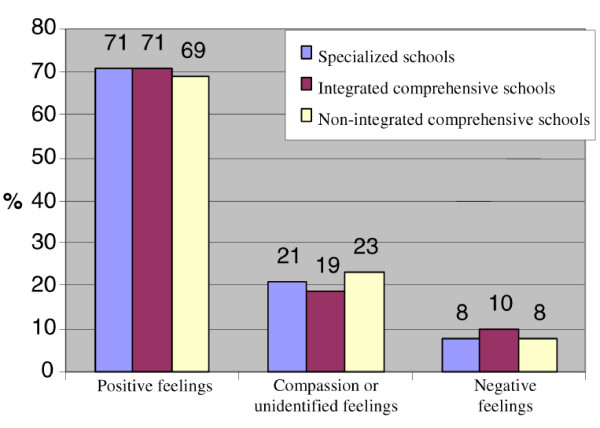
The attitudes of schoolchildren towards reciprocal feelings. The distribution of the percentage of schoolchildren without disabilities (integrated and non-integrated comprehensive schools) and schoolchildren with disabilities (specialized schools) according to the results of the emotional (positive, compassion or unidentified, negative feelings) components of reciprocal attitudes (HSAD, DSAH>1) in relation to the type of the school.